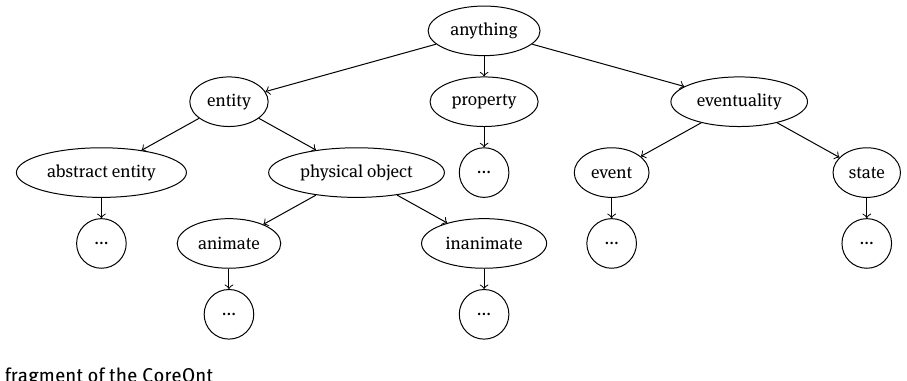
Figure 1: A fragment of the CoreOnt